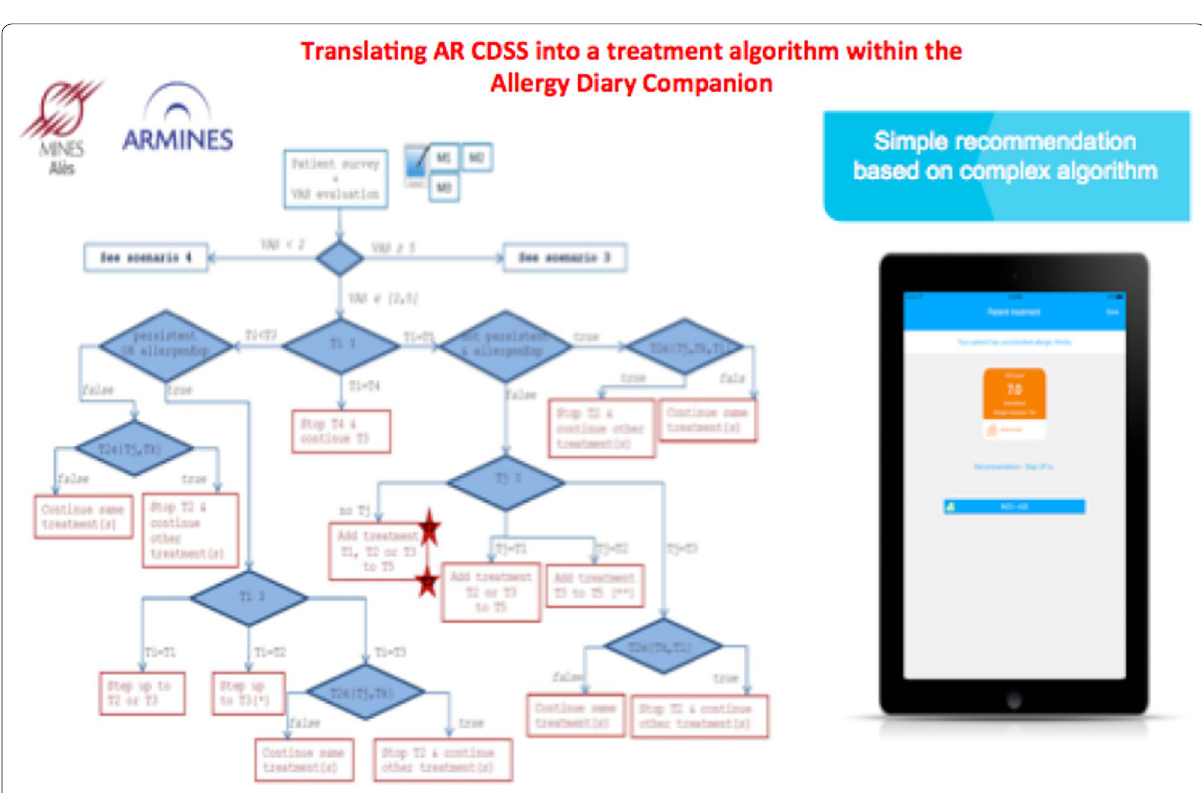
Fig. 5 CDSS digitalization